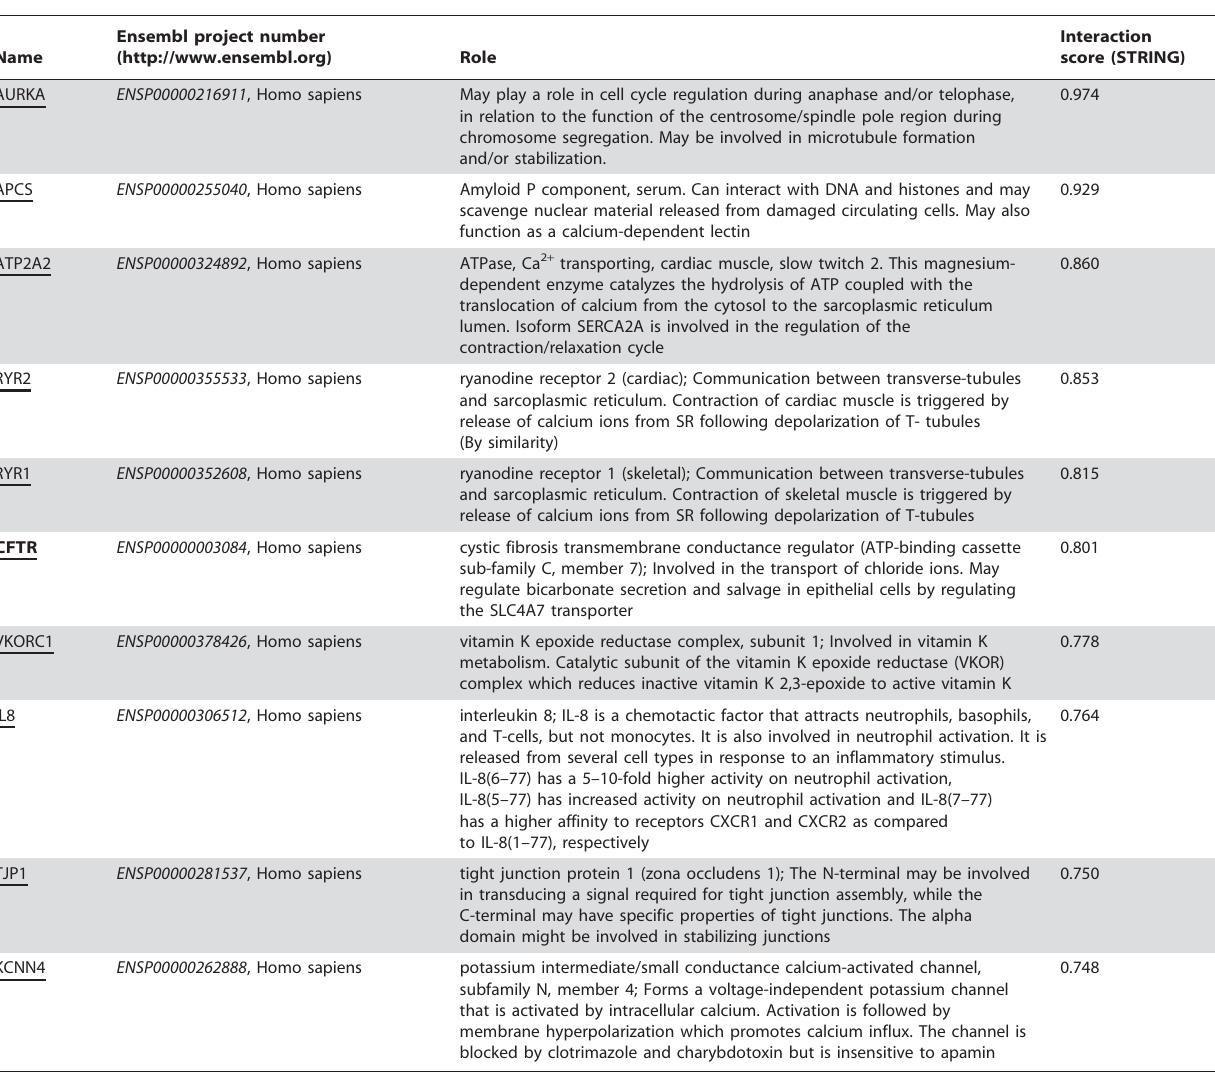
Table 3. Predicted Functional Partners for